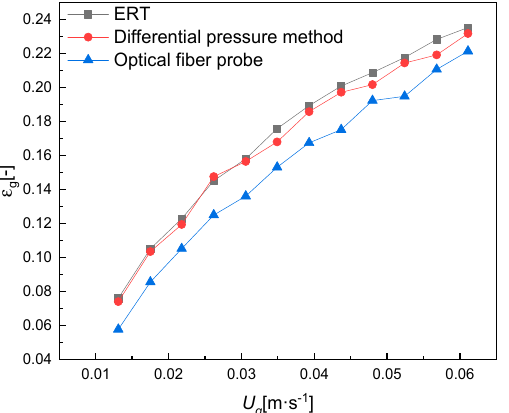
Figure 3. The gas holdup ε g measured by three methods under different superficial gas